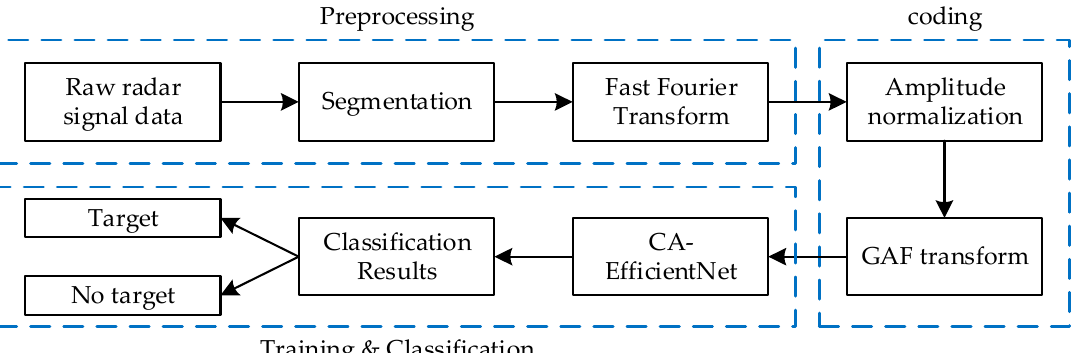
Figure 1. Block diagram of the proposed detection algorithm.